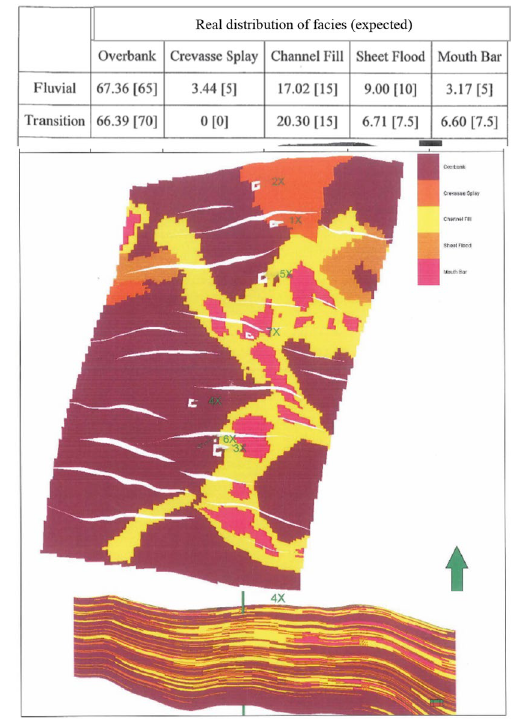
Fig. 32 Resulting model of case